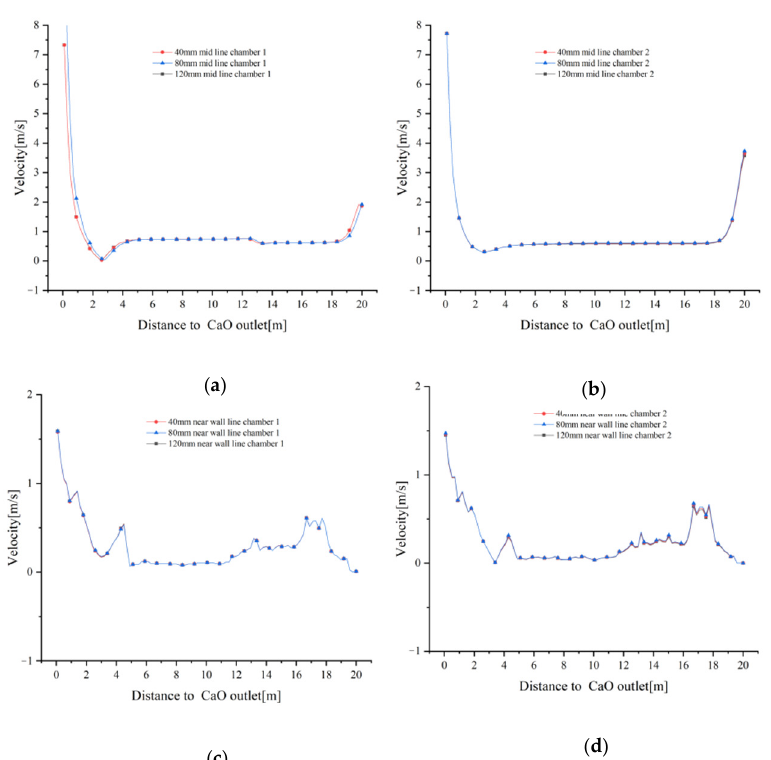
Figure 5. Comparison of gas velocities at mid lines and near wall lines in chamber 1 and 2. ( a ) Change in gas velocity at the mid line of chamber 1; ( b ) Change in gas velocity at the mid line of chamber 2; ( c ) Change in gas velocity at the near wall line of chamber 1; ( d ) Change in gas velocity at the near wall line of chamber 2.